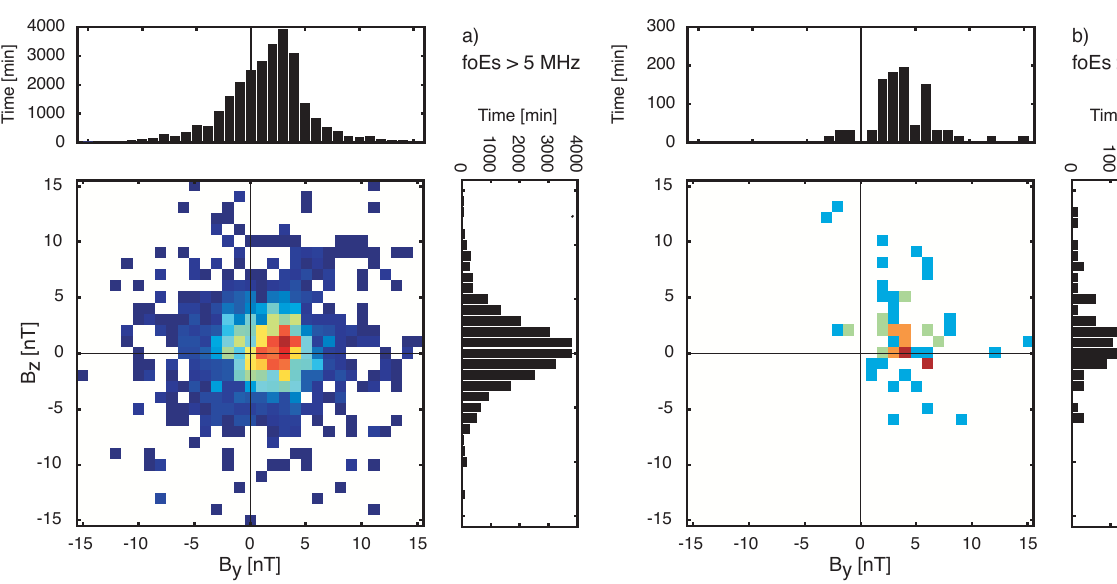
Fig. 3. Same as Fig. 2 for Thule in 1998–1999.